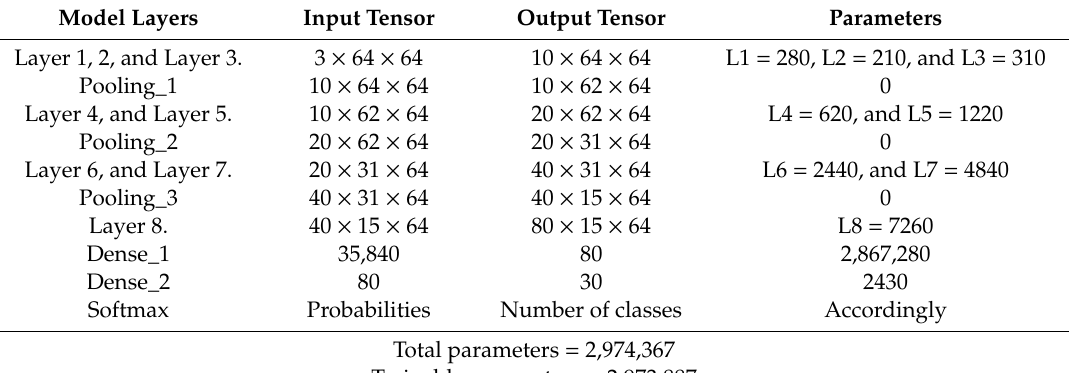
Layer 6, and Layer